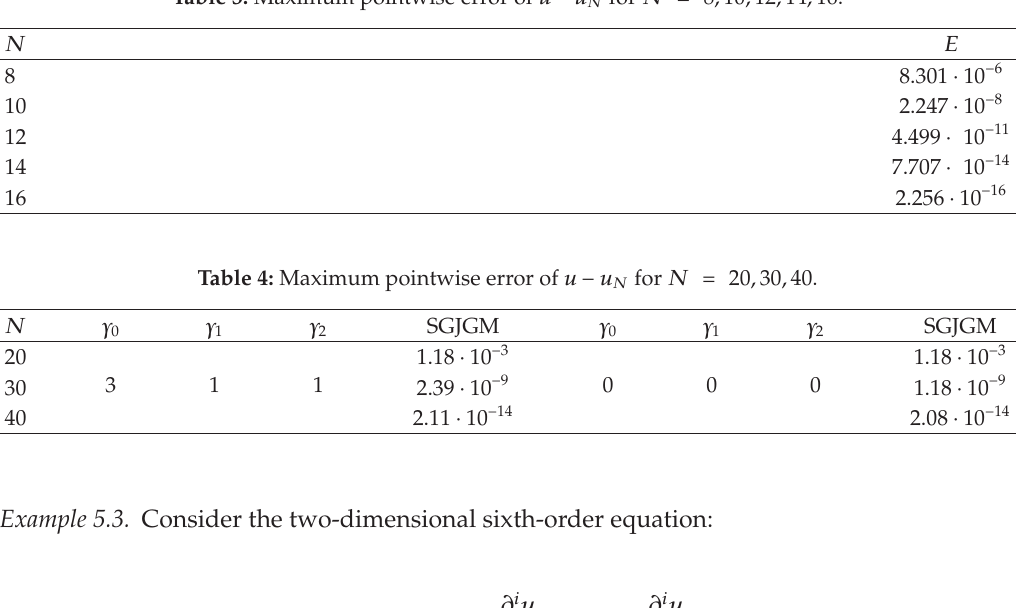
(cid:8) 8 , 10 , 12 , 14 , 16. N for N